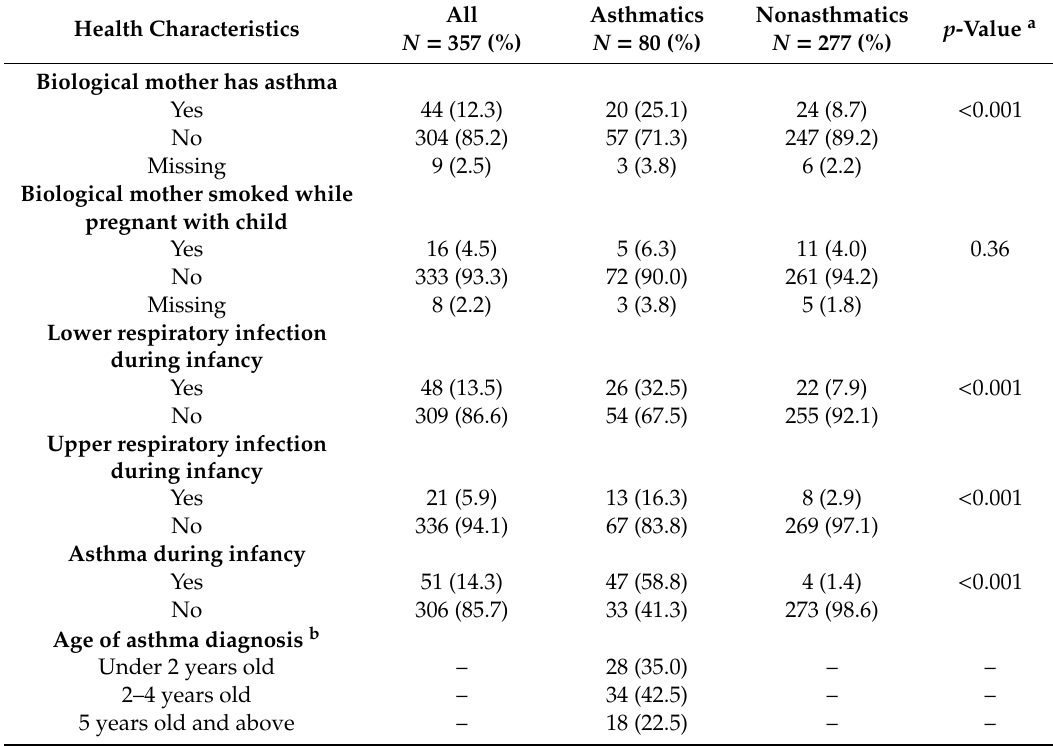
Table 2. Respiratory health history of school-age asthmatic and nonasthmatic